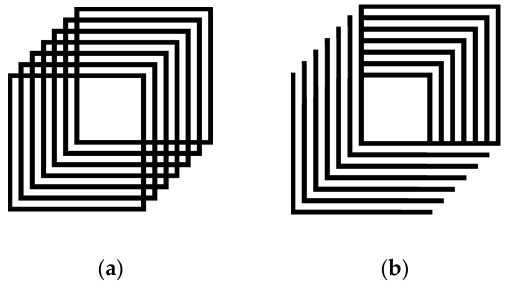
Figure 1. Necker cube stimuli. ( a ) Necker cube, two or more distinct percepts can be viewed; And ( b ) unambiguous prime and adaptation cube.